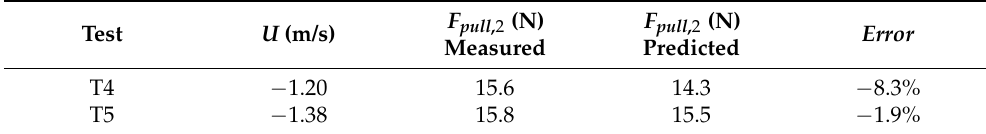
Table 3. Validation tests for hydrodynamic force coefficients (tested at different flow velocities using the ACM with s g = 3.23, and µ = 0.25).